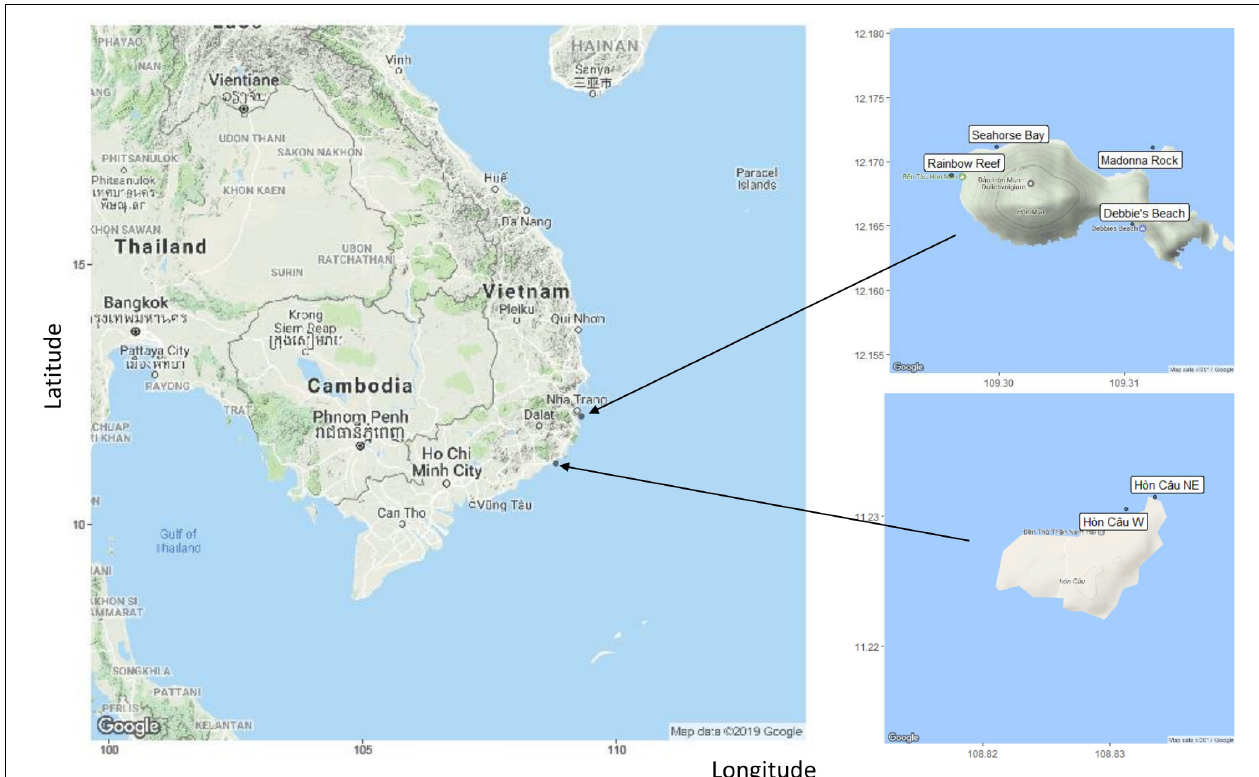
FIGURE 1 | Map of the six sites in Vietnam with axis describing the longitude and latitude of sites. Mun Island (upper right corner) contains four sites: Seahorse Bay, Madonna Rock, Rainbow Reef, and Debbie’s Beach. Cau Island (lower right corner) is located in south-central Vietnam and has two sites—Cu Lao Cau northeast (NE) and Cu Lao Cau west (W). (2017) (Google Maps,